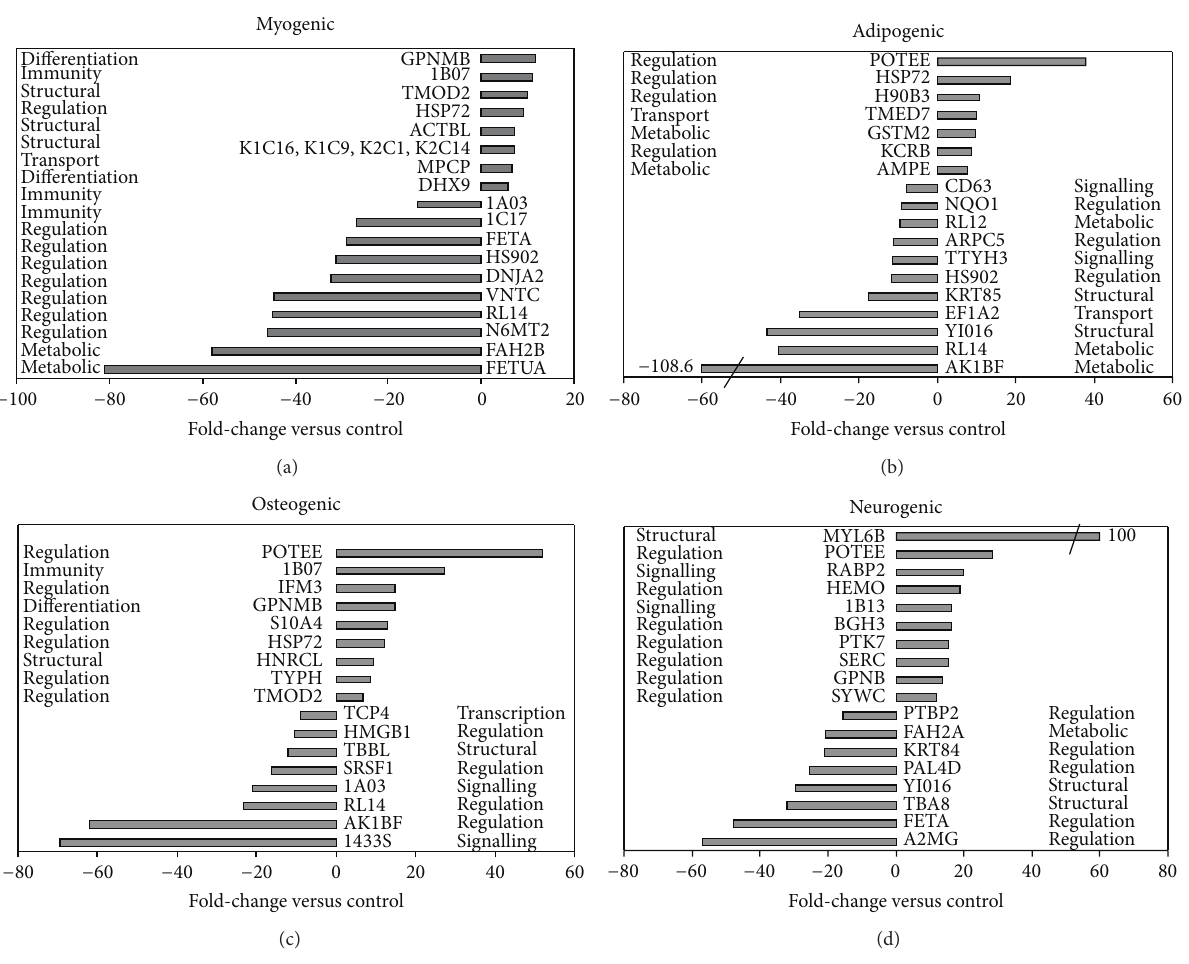
Figure 5: Highly up- and downregulated proteins in second-trimester AF-MSCs undergoing (a) myogenic, (b) adipogenic, (c) osteogenic, and (d) neurogenic differentiation. Each bar corresponds to the expression fold differences higher than six or lower than eight in each differentiating population as compared with undifferentiated